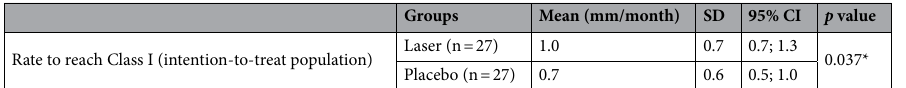
Table 5. Mean rate to reach Class I occlusion in the two groups. mm millimeters, SD standard deviation, *Indicates significant changes between the groups.